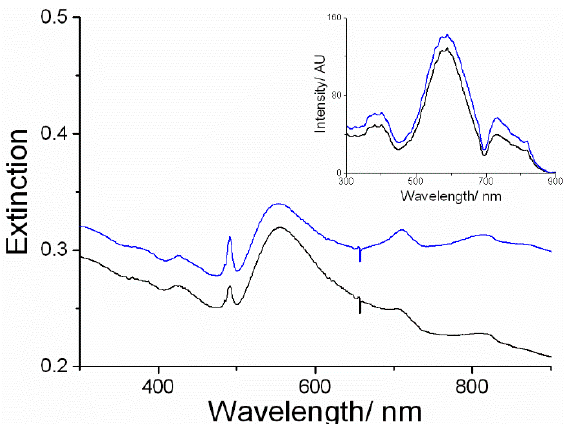
Figure 4. UV–vis spectra of the TPPS@AuNPs deposit left on the cuvette surface, obtained after washing with water, for D - ( black line ) and L - ( blue line ) histidine samples. The inset shows the corresponding RLS spectra.